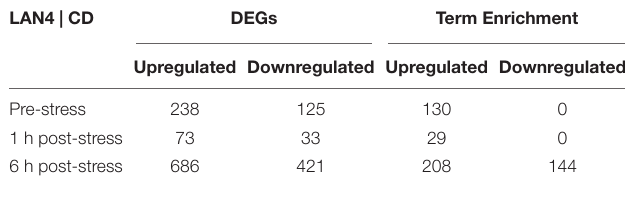
TABLE 4 | Significant differentially expressed genes (DEGs) and term enrichment per